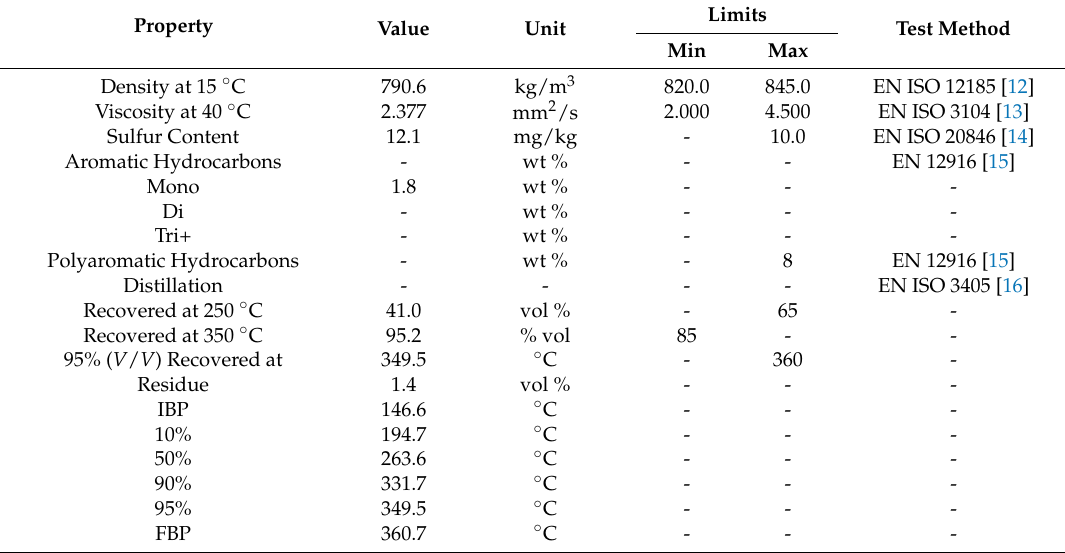
Table 3. Analysis of the hydroprocessed mid-distillate fraction of the pyrolysis